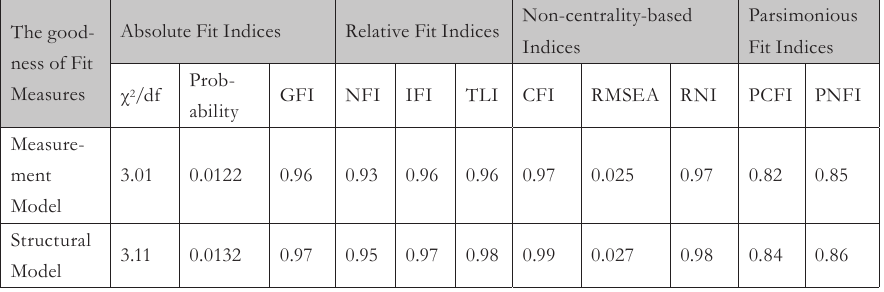
Tab. 2 – Fit Indices Measures. Source: own